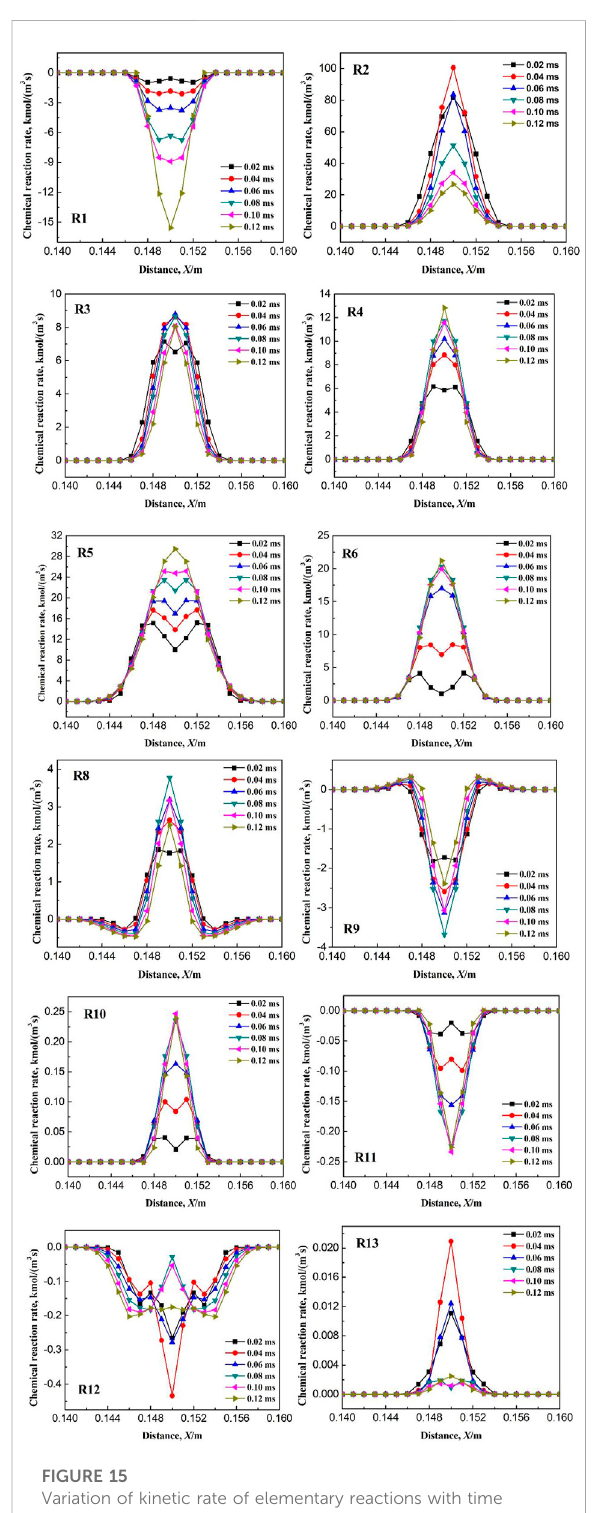
FIGURE 15 Variation of kinetic rate of elementary reactions with time when ignition radius is 4.5